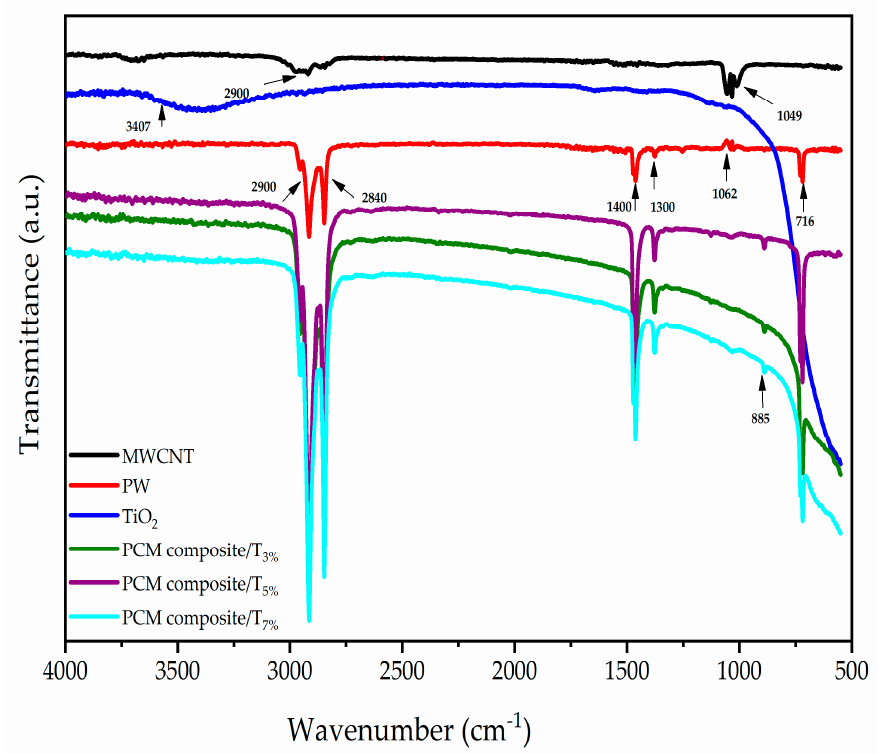
Figure 3. FTIR spectra of composites.